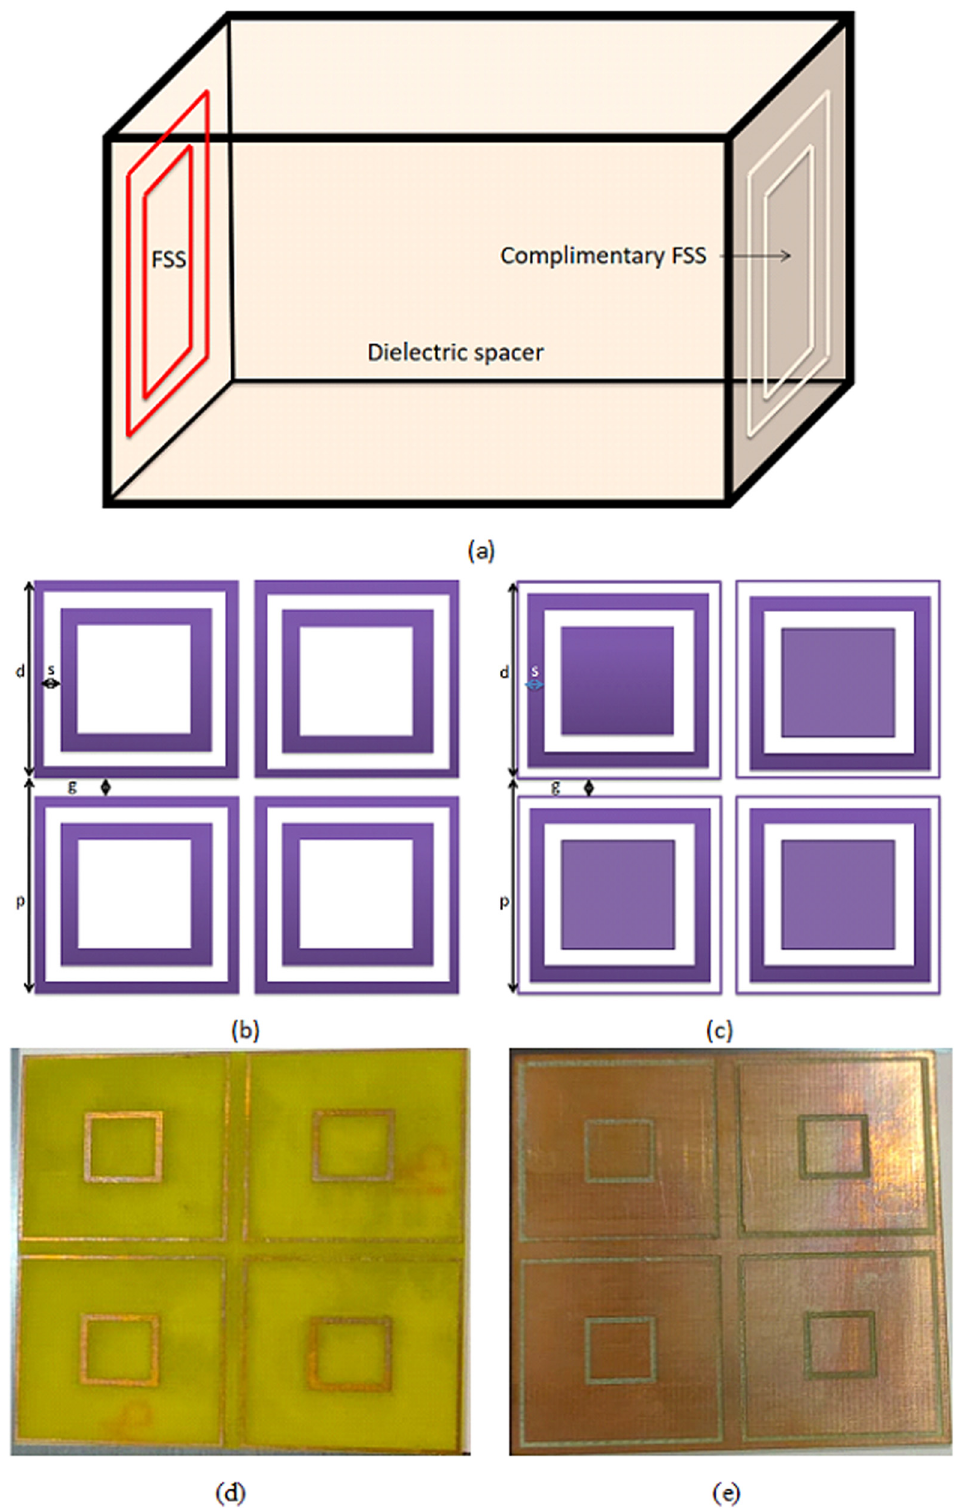
Figure 2: Con fi guration of FSS, ( a ) unit cell of CPFSS comprising DSLFSS and DSSFSS, ( b ) top layer consisting of DSLFSS, ( c ) bottom layer consisting of DSSFSS, ( d ) 2 2 × DSLFSS fabricated array, and ( e ) 2 2 × DSSFSS fabricated